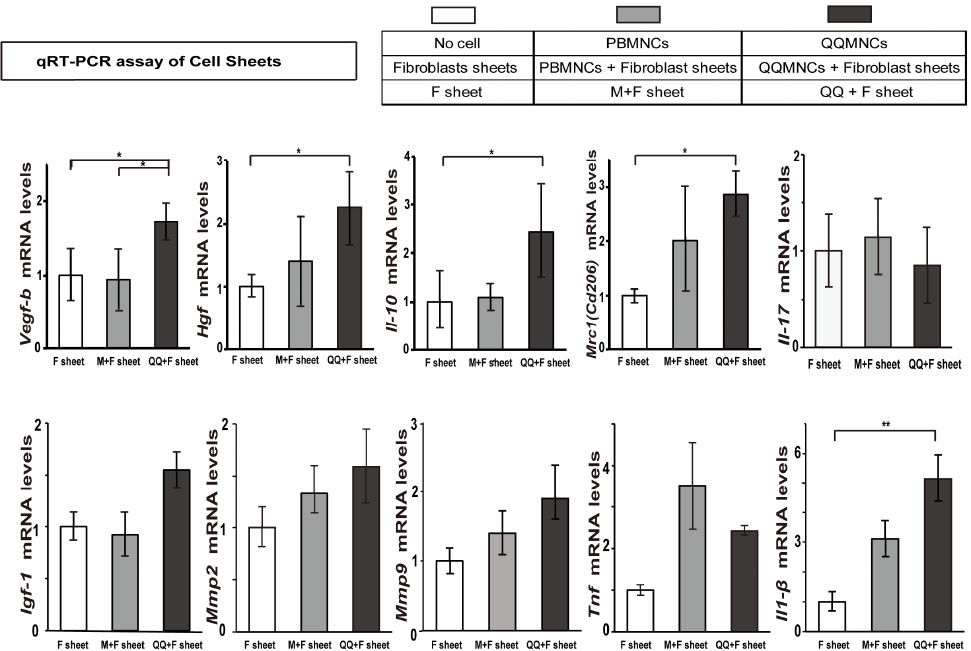
Figure 5. Analysis of gene expression profile in various F sheet with PBMNCs or QQMNCs derived from the EAM rats. QQMNCs were obtained from peripheral blood of the rat EAM model. Expression of genes encoding vascular regeneration, anti-inflammation, and cardioprotection factors ( Vegf-b, Hgf, Il-10, Cd206/Mrc1 ) were upregulated in the QQ+F sheet. Inflammatory gene expression ( Il-17 ) was downregulated in the QQ+F sheet. Inflammatory gene expression ( Il1- β ) was upregulated in the QQ+F sheet. Data are shown as mean ± SE. N = 5 per group. * p < 0.05 , ** p < 0.01. QQ+F sheet group. qRT-PCR: quantitative real-time polymerase chain reaction, M + F sheet: co-culture sheets of fibroblasts and PBMNCs, QQ+F sheet: co-culture sheets of fibroblasts and QQMNCs.